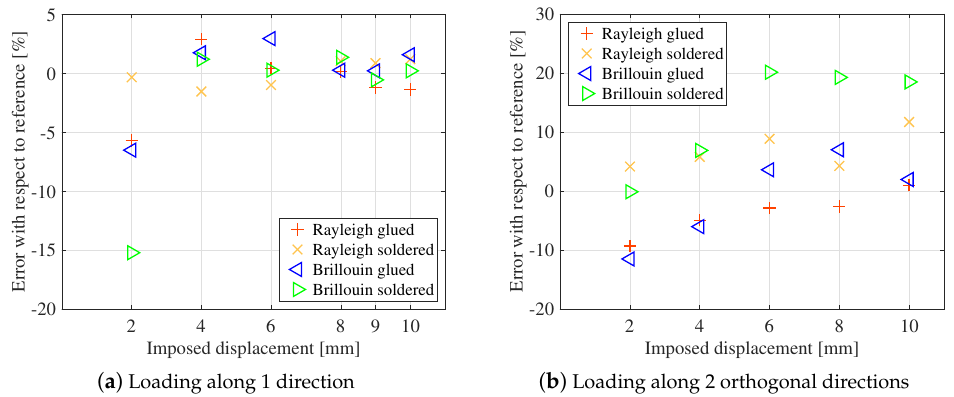
Figure 10. Error on convergence obtained by distributed